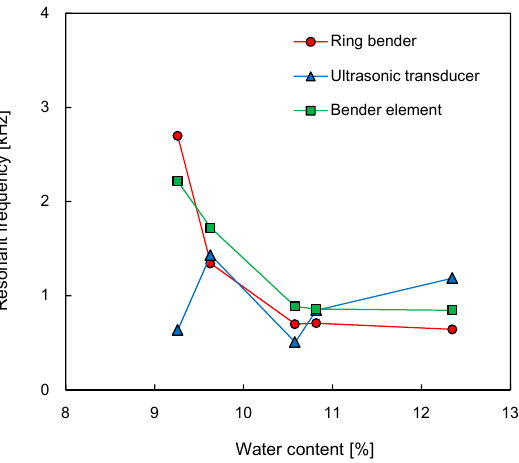
Figure 8. Frequency response curves obtained from the ring bender at the water content of ( a ) 9.3%; ( b ) 9.6%; ( c ) 10.6%; ( d ) 12.4%. FFT denotes fast Fourier transform.